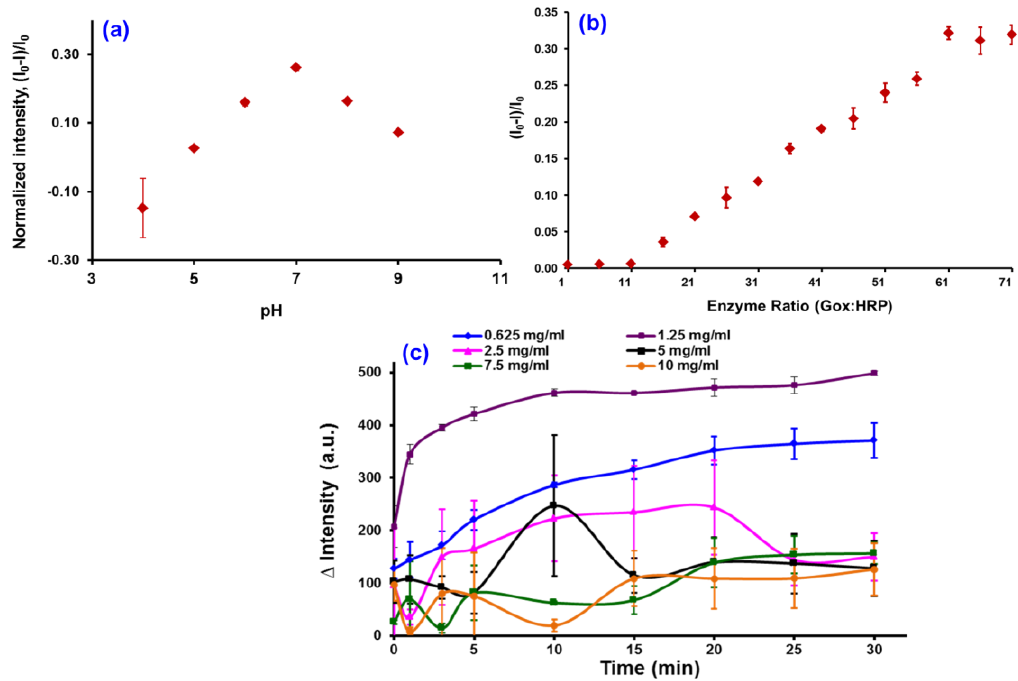
Figure 5. The effect of pH ( a ), enzyme ratio ( b ), and QD concentration ( c ) towards the fluorescence intensity.